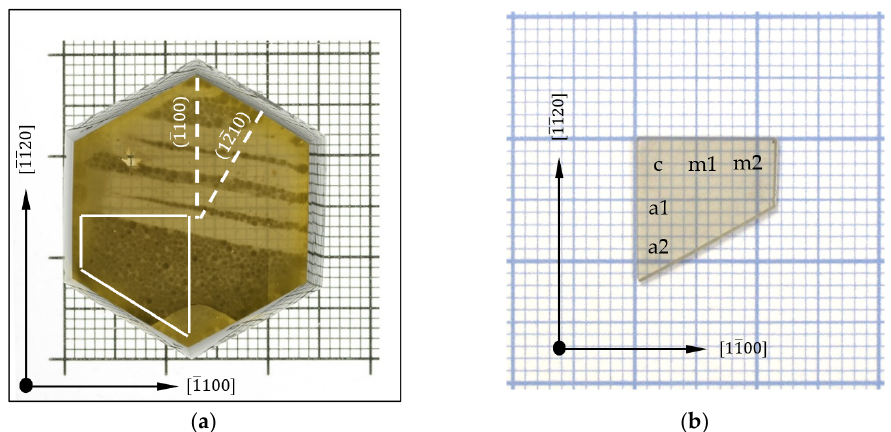
Figure 2. ( a ) Top view of a hexagonal Am-GaN crystal grown on a lens seed; white dashed lines indicate the location of slicing for samples with non-polar planes; white solid trapezoid represents a sample (see b ) obtained by cutting a slice in the (0001(cid:3364)) plane. ( b ) Slice of the sample that was cut and prepared for DSE; view on the (0001) plane; EPD was determined at indicated points; grid line 1 mm.